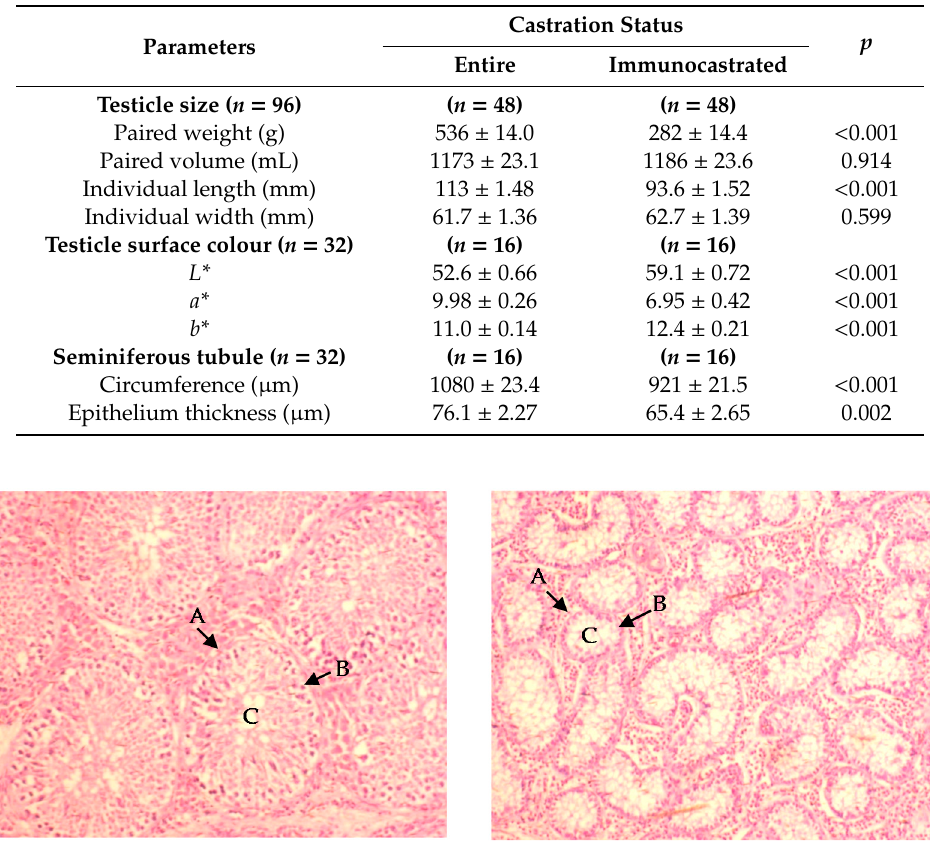
Figure 1. Micrographs of testicular tissue for entire ( left ) and immunocastrated ( right ) pigs slaughtered at 24 weeks of age, 4 weeks after the second immunocastration vaccination with Improvac (40 × magnification). Immunocastration resulted in atrophy of the seminiferous tubules (A), loss of spermatocytes (B), and increased lumen size (C).